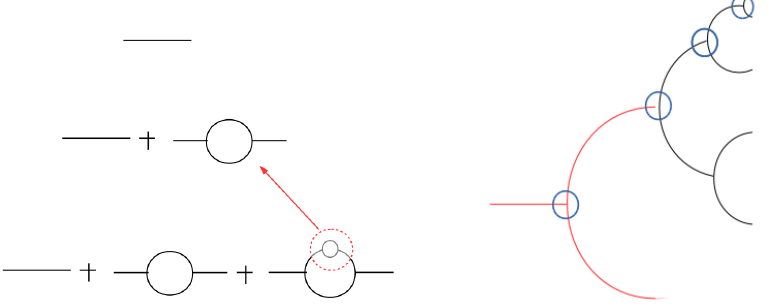
Figure 1. Left panel: Diagrams showing the scaling properties of Yang–Mills fields. It is shown the loops at different orders in the perturbative expansion. Right panel: Diagrams of multiparticle production in pp collisions. The initial parton (first black line from the left) may be considered as a constituent of another parton (first red line from the left). The effective vertex couplings, which are given by the second expression in Equation (22) are indicated by circles. The figure in the left panel is taken from ref.